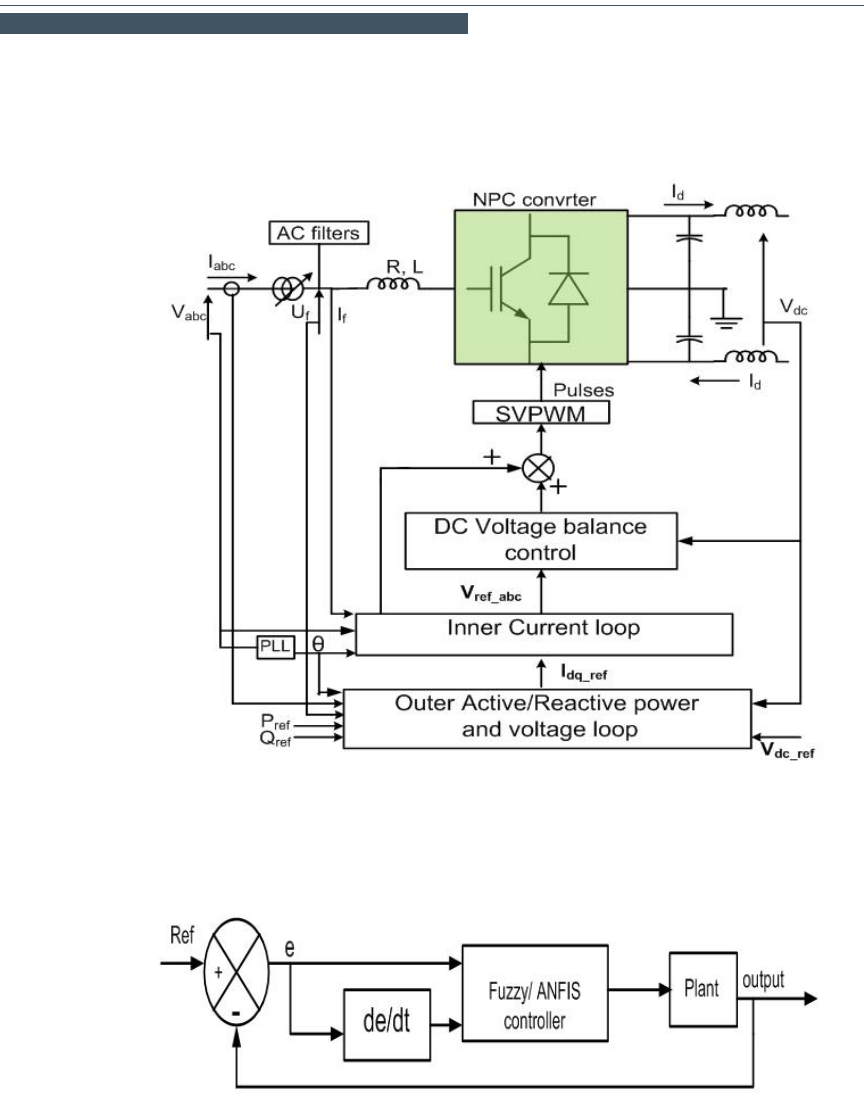
Figure 2. (a) Control structure (b) sub block of inner and outer loops of the proposed controller.